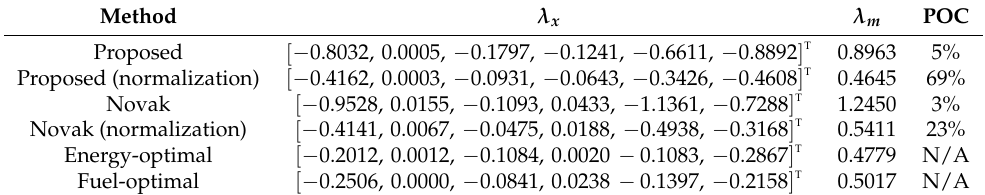
Table 7. Initial costates and POC of different methods.